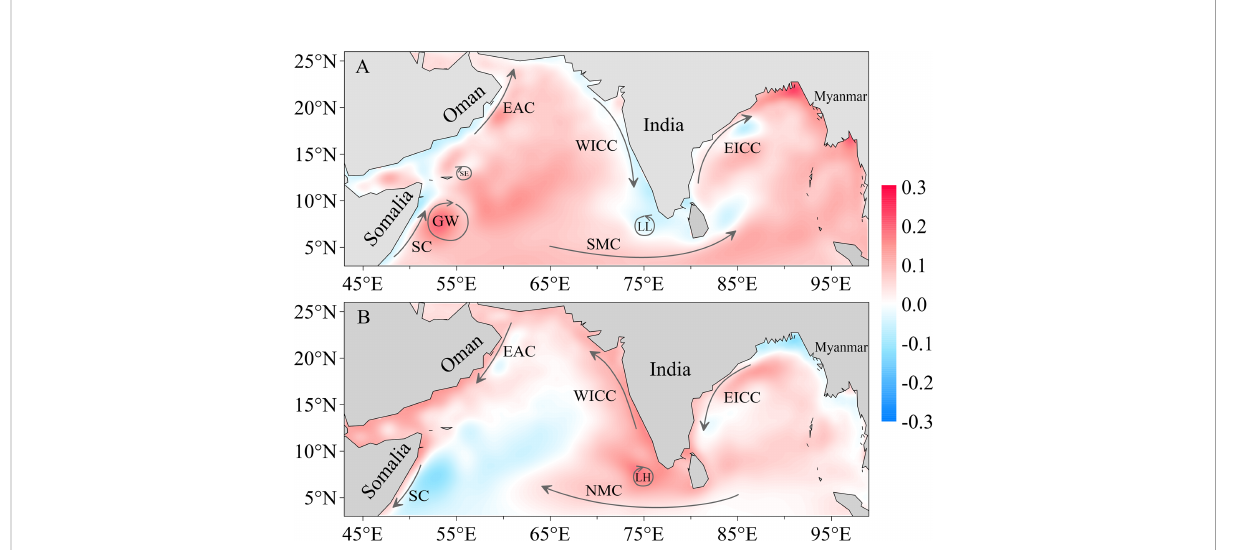
FIGURE 1 Schematic currents and eddies in the north Indian Ocean during the summer (A) and winter (B) monsoon. The abbreviations are as follows: SC, Somali Current; EAC, East Arabian Current; SMC, Southwest Monsoon Current; NMC, Northeast Monsoon Current; WICC, West India Coastal Current; EICC, East Indian Coastal Current; GW, Great Whirl; SE, Socotra Eddy; LH, Laccadive High; LL, Laccadive Low. The arrows show the direction of currents and the color shading represents the mean sea level anomaly from June to August (A) and from December to January (B) (unit: